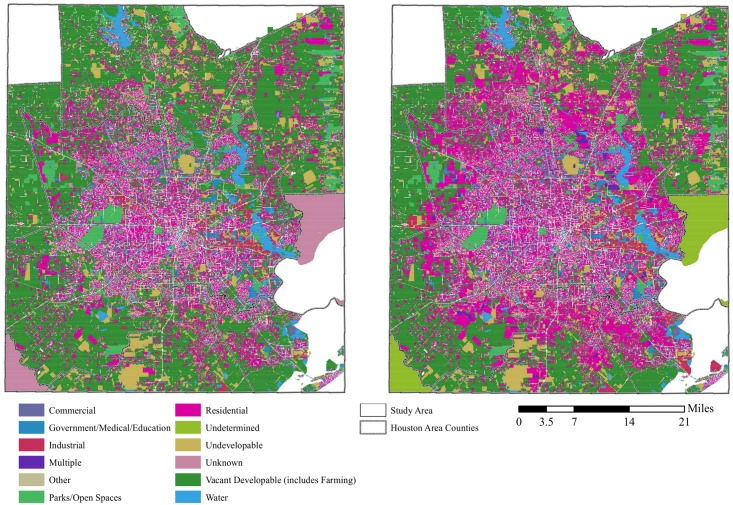
H-GAC land use, by parcel, present (2010; left) and future (2040; right).